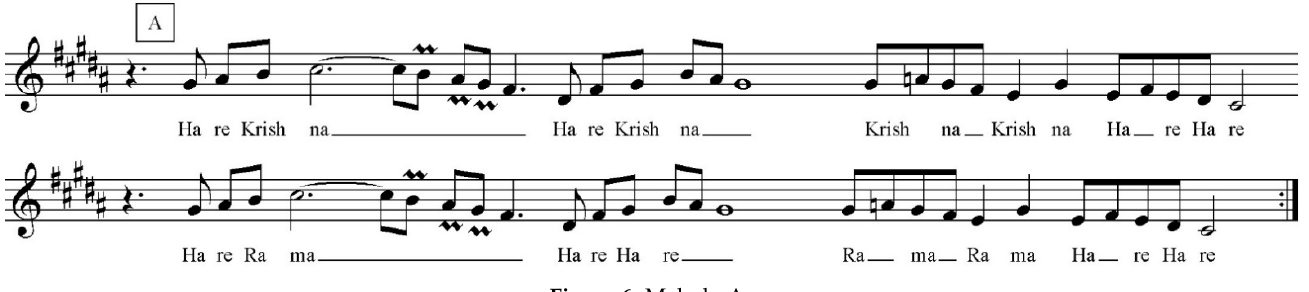
Figure 6. Melody A. Figure 6. Melody A.